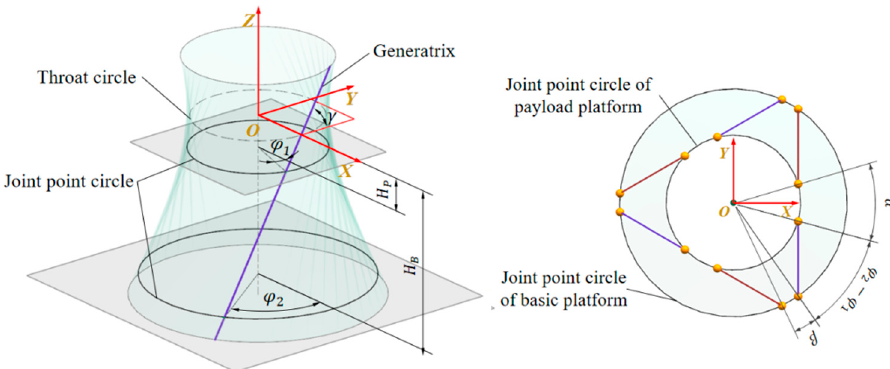
Figure 5. Diagram of parameter decomposition.